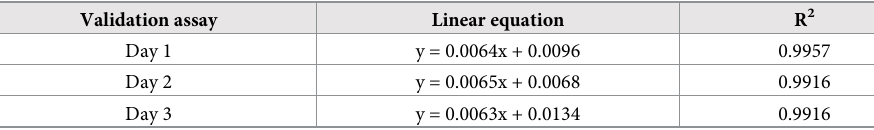
Table 6. Standard curve equations and their coefficients of determination.